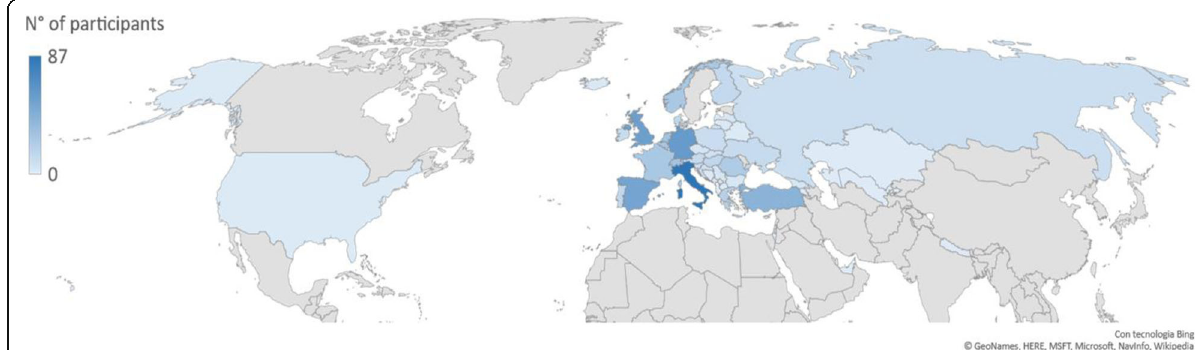
Fig. 2 Geographic distribution of survey